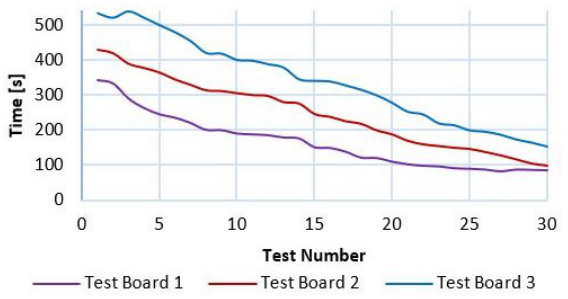
Figure 26. Number of tests performed and the response time